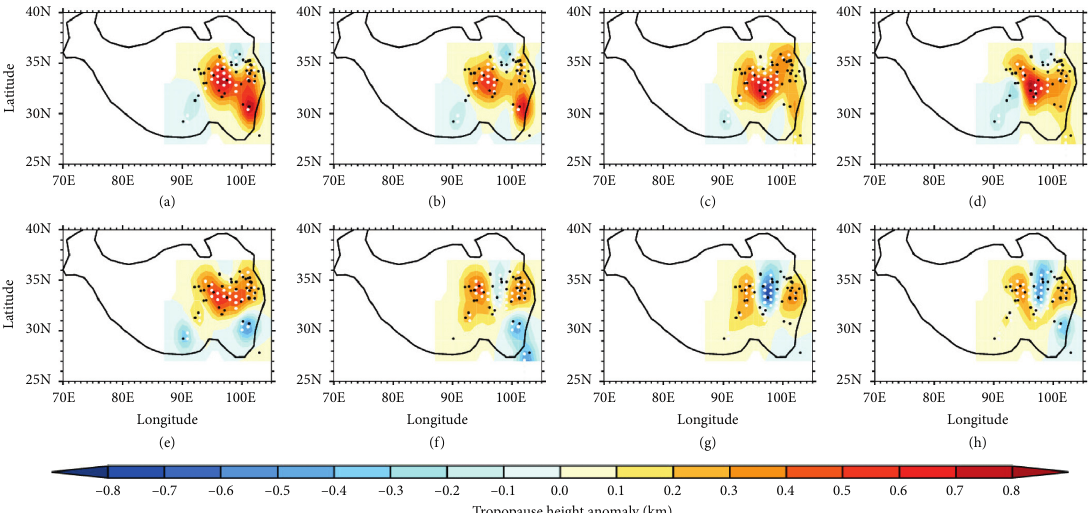
Figure 3: The composite horizontal distributions of anomalous tropopause height (units: km) for the (a) 7th day, (b) 6th day, (c) 5th day, (d) 4th day, (e) 3rd day, (f) 2nd day, (g) 1st day, and (h) 0 day before the OCS onset for 41 OCS events. The white dotted areas indicate that the anomalies are statistically significant at a 95% confidence level (based on a two-sided Student’s t -test). The black dots indicate the locations of the 41 OCS